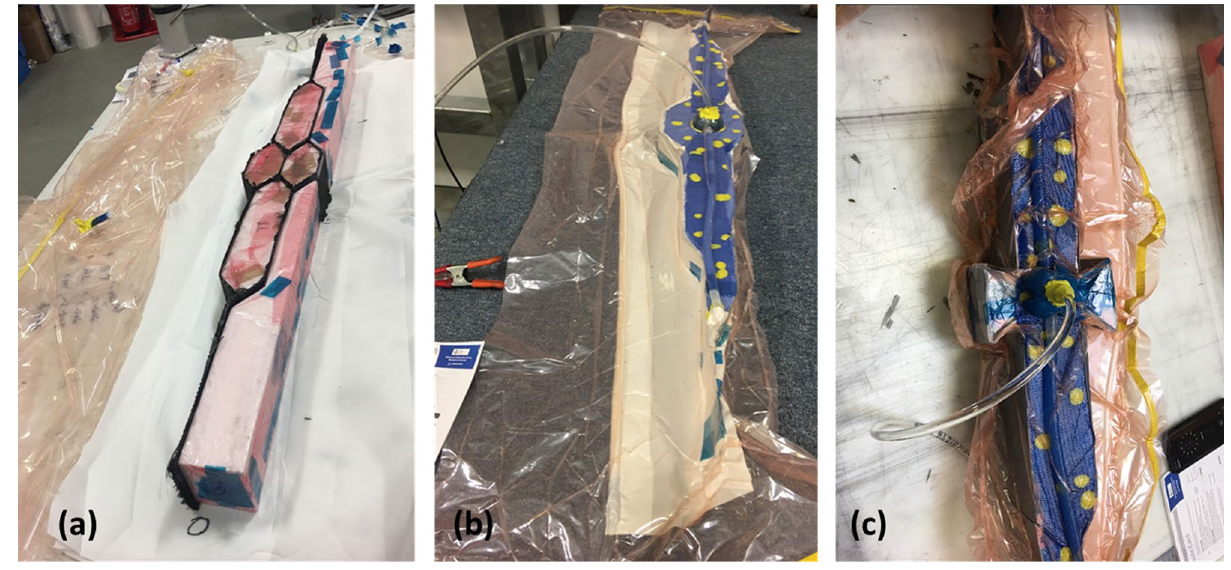
Figure 9. Bagging process of honeycomb preform ( a ) and resin infusion of honeycomb ( b ) and auxetic ( c ) assembles.